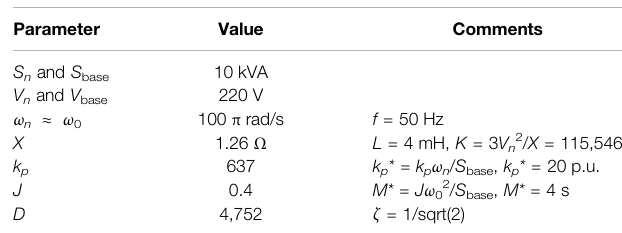
TABLE 1 | Same parameters